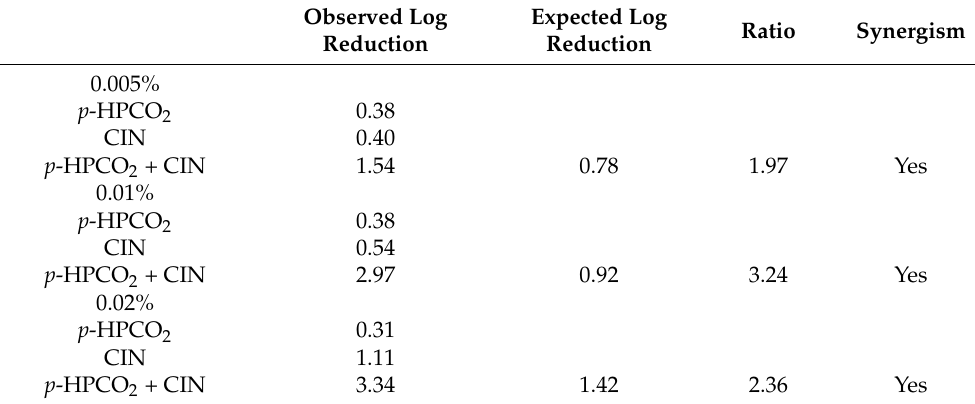
Figure 2. Survival of Saccharomyces cerevisiae after treatment with cinnamon oil (CIN), petit -high pressure CO 2 ( p -HPCO 2 ), and CIN + p -HPCO 2 under 1.3 MPa for 2 h at 25 ° C . Different letters above bars mean significant differences ( p < 0.05). Table 2. Synergism between antifungal effect against Saccharomyces cerevisiae of cinnamon oil (CIN) and petit -high pressure CO 2 ( p -HPCO 2 ) under 1.3 MPa for 2 h at 25 °C.